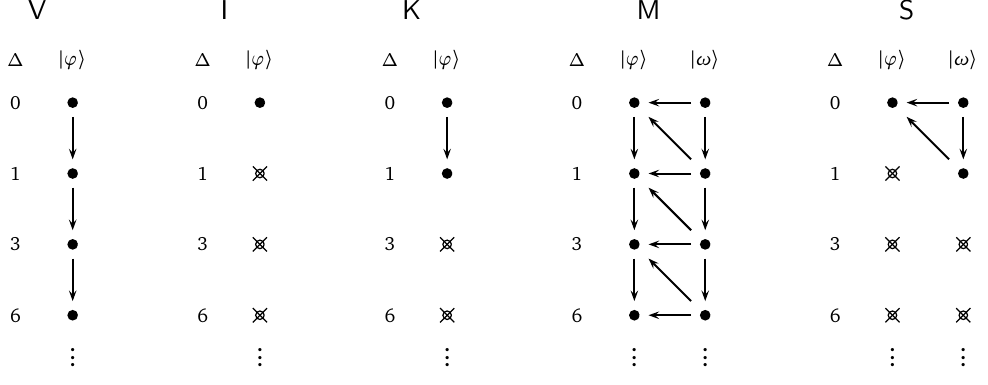
Figure 4: The Loewy diagrams for the modules V , I , K , M and S